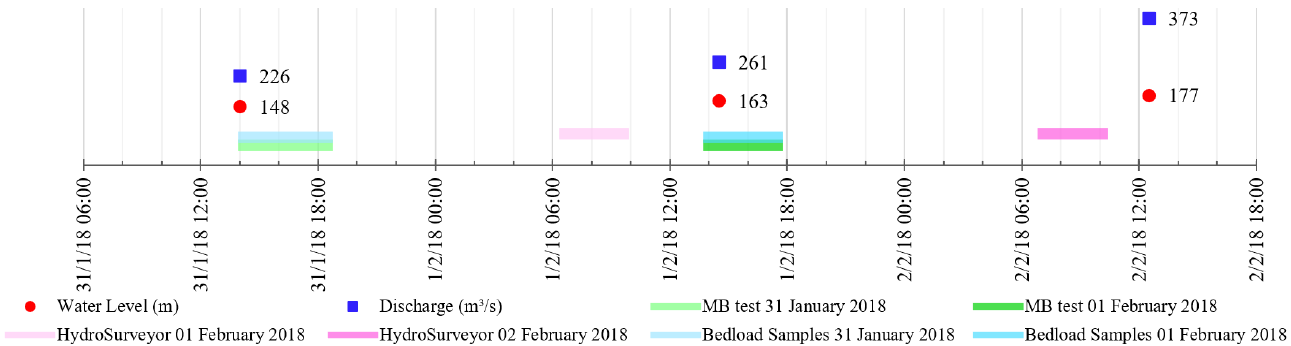
Figure 3. Temporal resolution of field surveys.